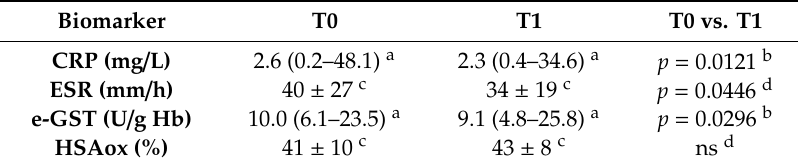
Table 7. Inflammatory and oxidative stress biomarkers of CKD patients.